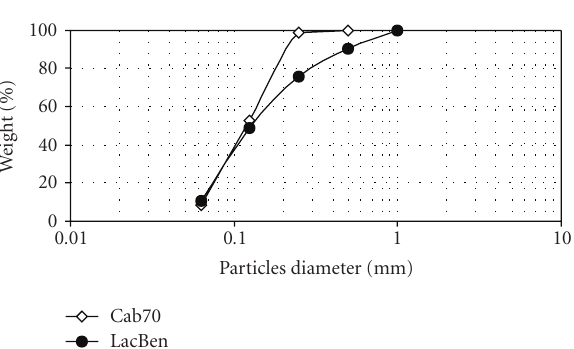
Figure 1: Grain size distribution curves of Cab70 and LacBen.